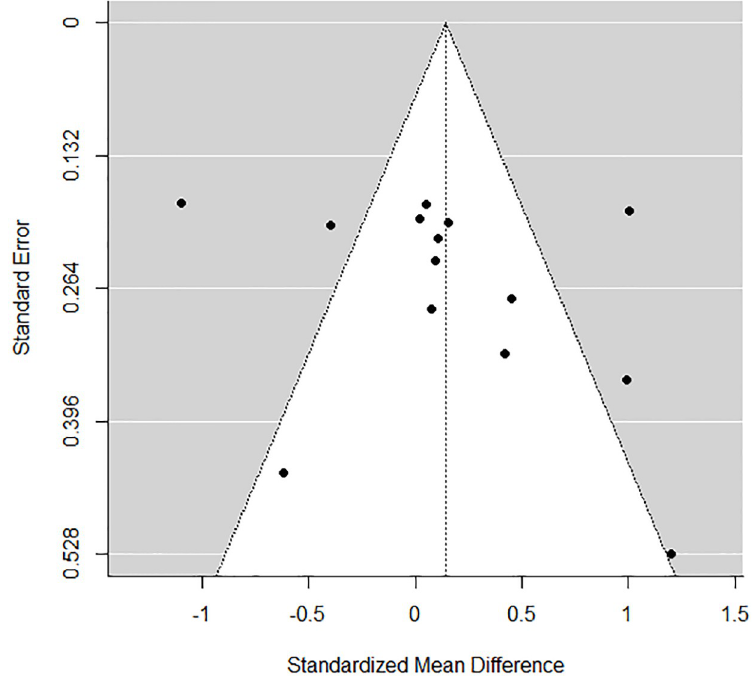
Fig 3. Funnel plot of studies examining the effect of music listening on psychophysiological recovery from stress. The small number of studies renders it difficult to visually inspect asymmetry, and thus precludes an accurate assessment of publication